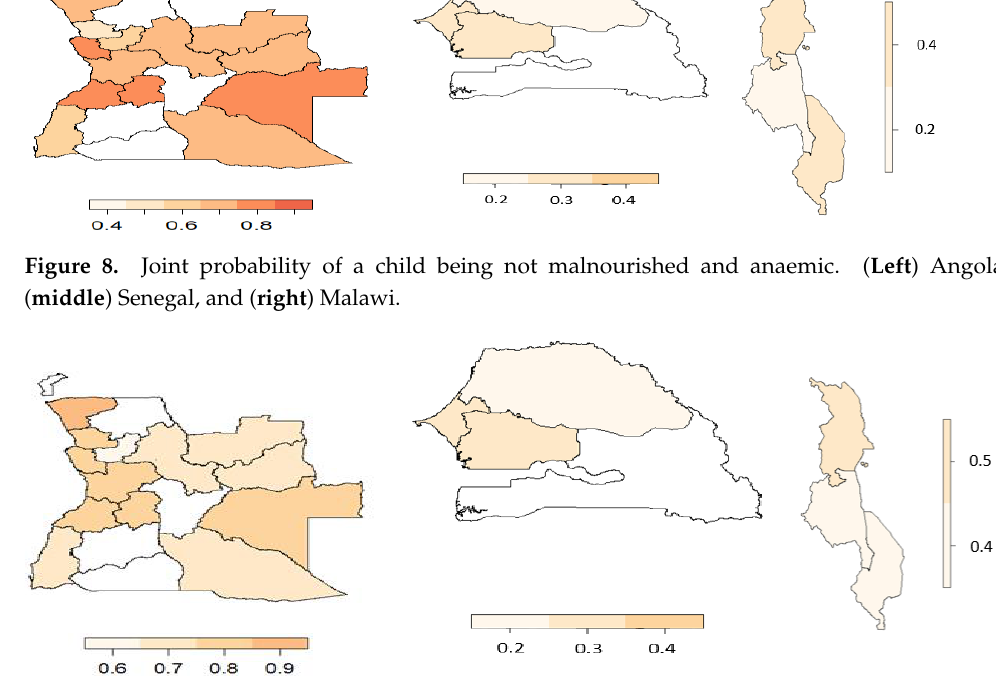
Figure 9. Joint probability of a child being malnourished and not anaemic. ( Left ) Angola, ( middle ) Senegal, and ( right ) Malawi .